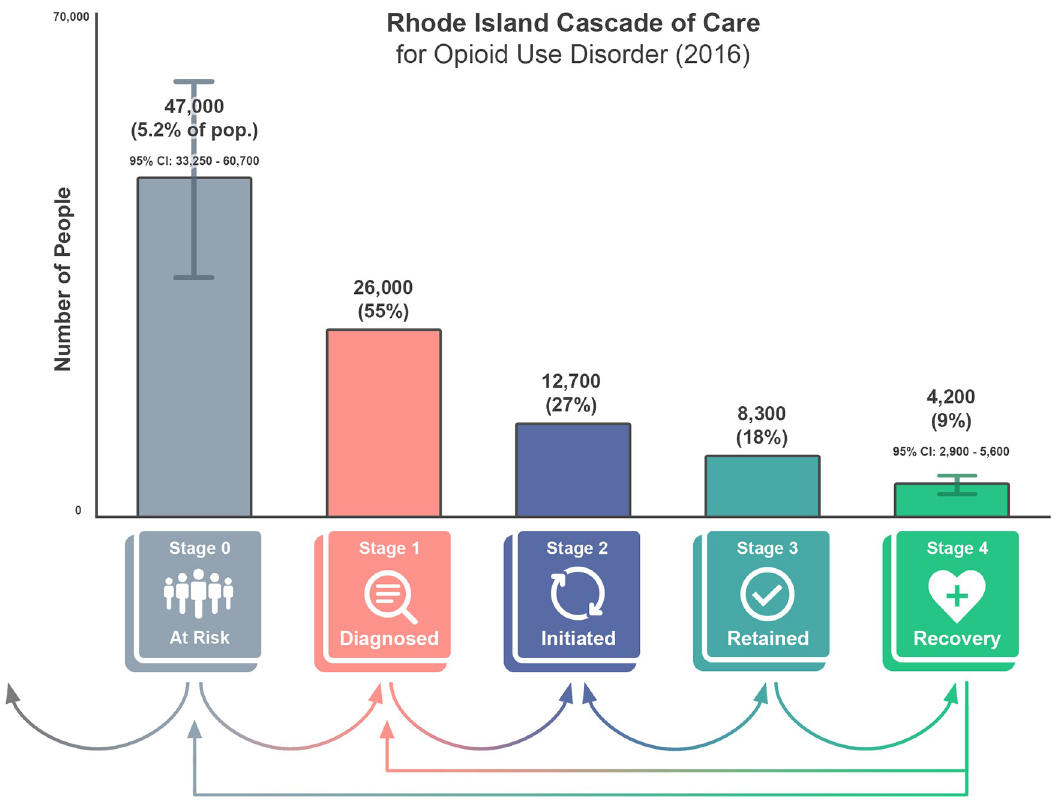
Fig 2. Results for the Rhode Island Cascade of Care. Stages 0 and 4 represent estimates from national survey data sources. Stage 1 represents statewide claims data from the HealthFacts RI all-payer claims database (APCD). Stages 2 and 3 represent combined estimates from the Rhode Island Prescription Drug Monitoring Program (PDMP) and the Behavioral Health On-Line Database (BHOLD), which include treatment claims for methadone and records for buprenorphine prescriptions. All estimates are approximate and considered preliminary. Credit: Maxwell Krieger, Brown